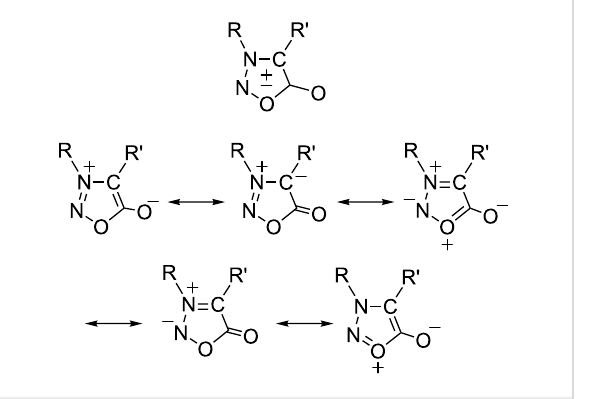
Figure 2: Illustration of intramolecular [3 + 2] cycloadditions.